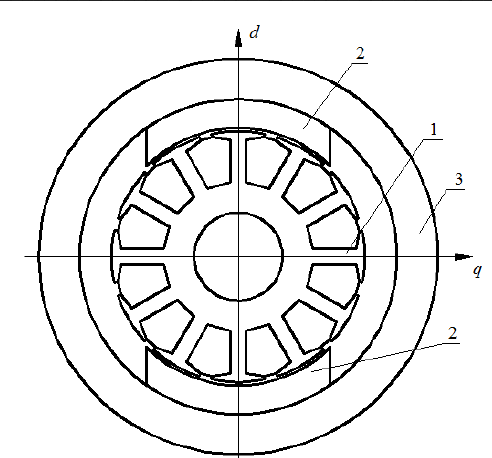
Fig. 1. Construction scheme of SynRM with salient-pole outer rotor and ferromagnetic yoke.